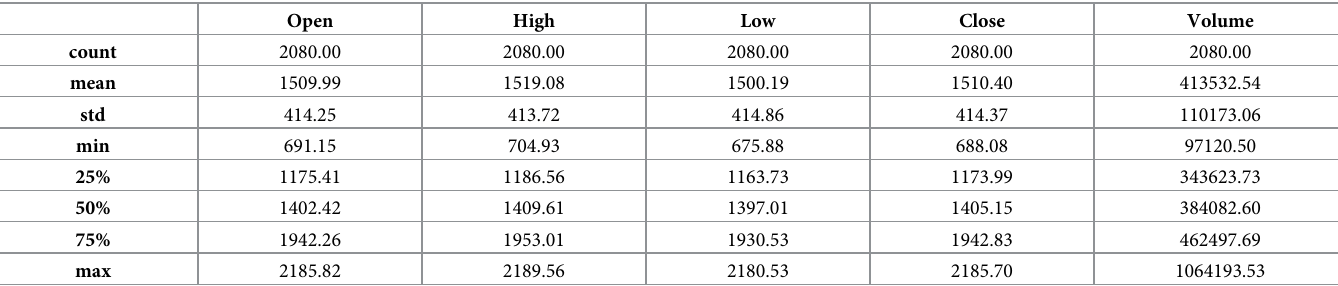
Table 1. Summary statistics of selected input variables (historical trading data) (S&P500).